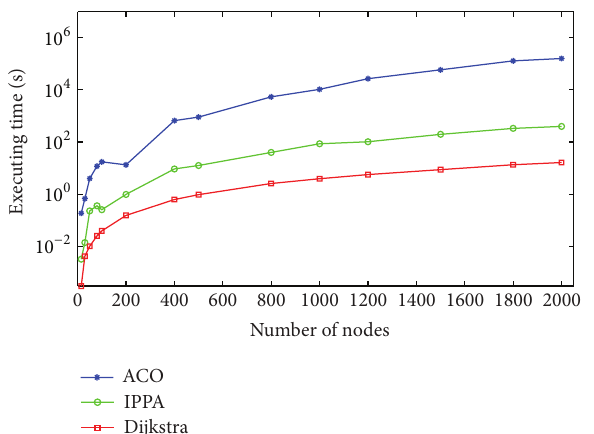
Figure 5: Comparison of running time on randomly generated net- works. ACO refers to the ant colony optimization algorithm while IPPA refers to the improved Physarum polycephalum algorithm.